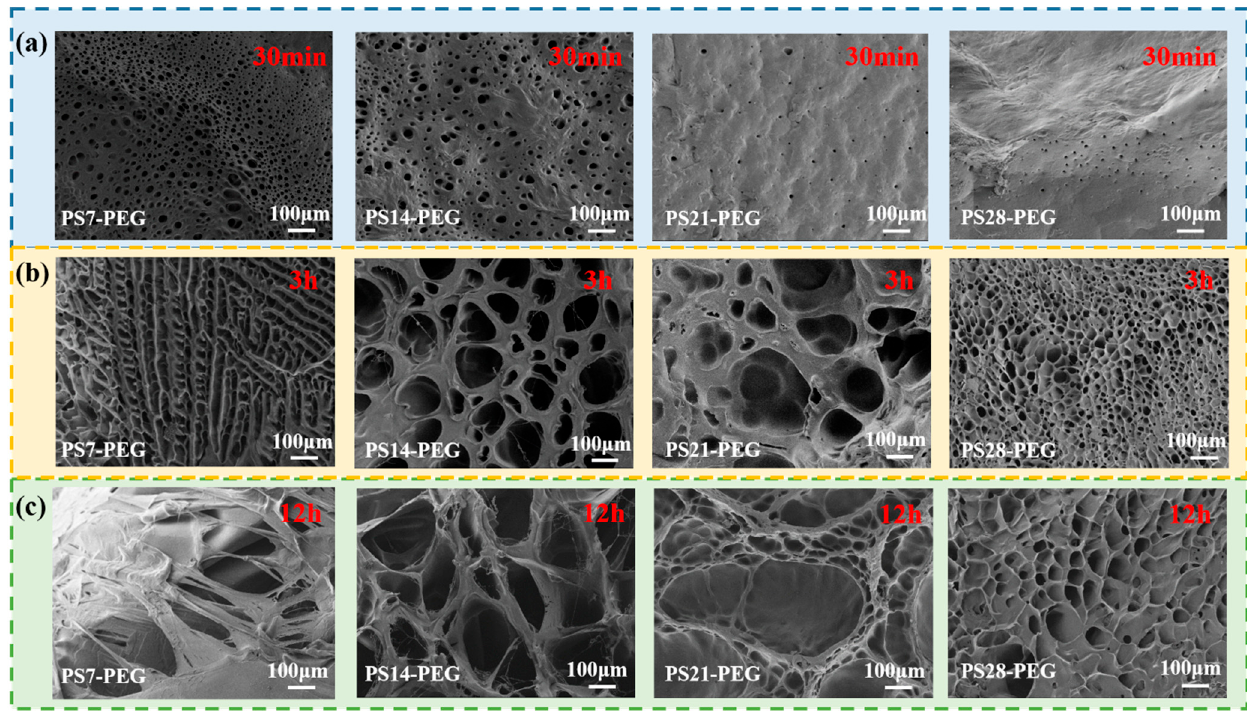
Figure 10. Surface morphology of the SFDH samples: ( a ) 30 min, ( b ) 3 h, ( c ) 12 h.